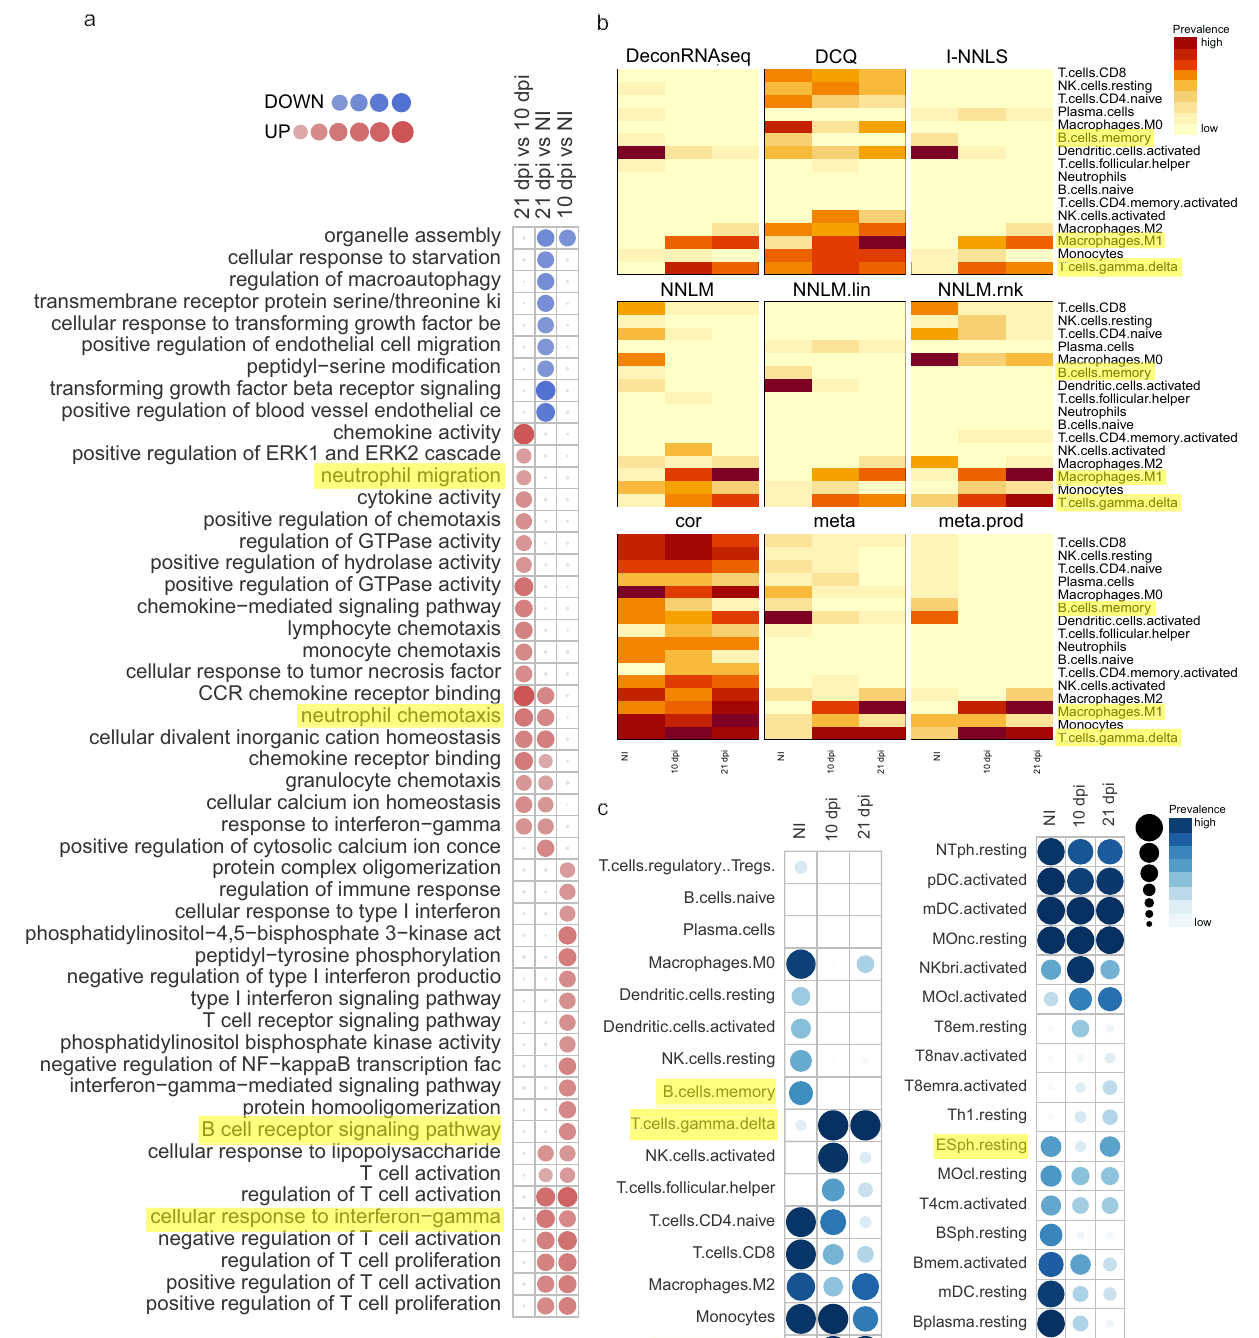
Fig. 7 | Gene ontology analysis and cell type mapping of T. b. brucei infected lung tissue.a Activation matrix visualizing the enrichment ofGO terms across the different comparisons (21 dpi vs 10 dpi, 21 dpi vs NI, 10 dpi vs NI). Red colour corresponds to upregulation and blue colour corresponds to downregulation of the corresponding pathway. Circle size corresponds to the number of genes involvedinthespeci fi cpathway. b Heatmapvisualizingthe distributionofinferred immune cell types based on nCounter digital transcriptomics for different com- putationaldeconvolutionmethods(DeconRNAseq,DCQ,I-NNLS,NNLM,NNLM.lin,